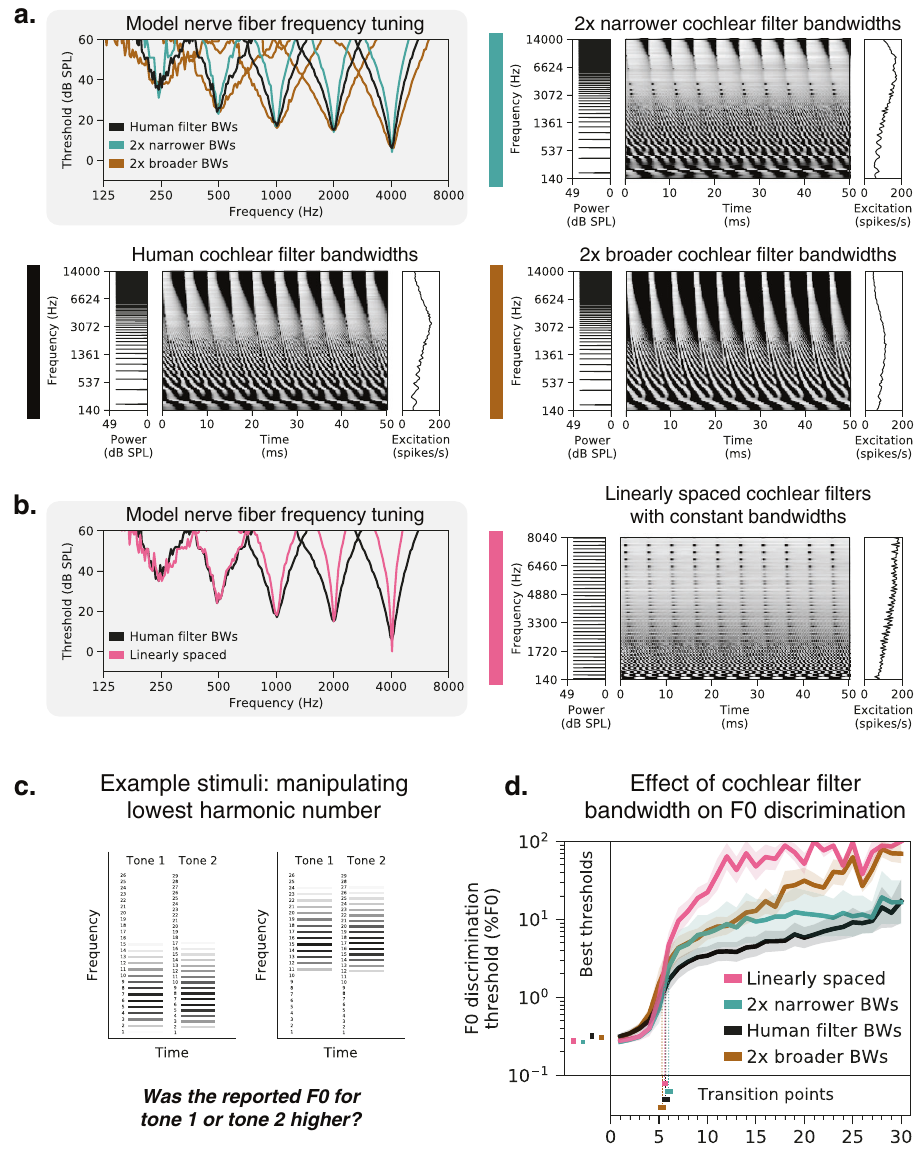
Fig. 6 Cochlear frequency tuning has relatively little effect on pitch perception. a Cochlear fi lter bandwidths were scaled to be two times narrower or two times broader than those estimated for normal-hearing humans. This manipulation is evident in the width of auditory nerve tuning curves measured from fi ve individual fi bers per condition (upper left panel). Tuning curves plot thresholds for each fi ber as a function of pure tone frequency. Right and lower left panels show simulated auditory nerve representations of the same stimulus (harmonic tone with 200 Hz F0) for each bandwidth condition. Each peripheral representation is fl anked by the stimulus power spectrum and the time-averaged auditory nerve excitation pattern. The excitation patterns are altered by changes in frequency selectivity, with coarser tuning yielding less pronounced peaks for individual harmonics, as expected. b Cochlear fi lters modeled on the human ear were replaced with a set of linearly spaced fi lters with constant bandwidths in Hz. Pure tone tuning curves measured with linearly spaced fi lters are much sharper than those estimated for humans at higher frequencies (left panel; note the log-spaced frequency scale). The right panel shows the simulated auditory nerve representation of the stimulus from a with linearly spaced cochlear fi lters. In this condition, all harmonics are equally resolved by the cochlear fi lters and thus equally likely to produce peaks in the time-averaged excitation pattern. c Schematic of stimuli used to measure F0 discrimination thresholds. Gray level denotes amplitude. Two example trials are shown, with two different lowest harmonic numbers. d F0 discrimination thresholds as a function of lowest harmonic number, measured from networks trained and tested with each of the four peripheral model con fi gurations depicted in a and b . The best thresholds and the transition points from good to poor thresholds (de fi ned as the lowest harmonic number for which thresholds fi rst exceeded 1%) are re-plotted to the left of and below the main axes, respectively. Lines plot means across the ten networks; error bars indicate 95% con fi dence intervals bootstrapped across the ten F0 discrimination behavior (Fig. 6c, d). Broadening fi lters by a Narrowing fi lters by a factor of two yielded an improvement in factor of two had no signi fi cant effect on the best thresholds best thresholds that was statistically signi fi cant ( t (18) = 2.74, ( t (18) = 0.40, p = 0.69, t -test comparing thresholds when p = 0.01, d = 1.23) but very small (0.27% vs. 0.32% for the lowest harmonic number = 1 to the human tuning condition). networks with normal human tuning). Linearly spaced cochlear